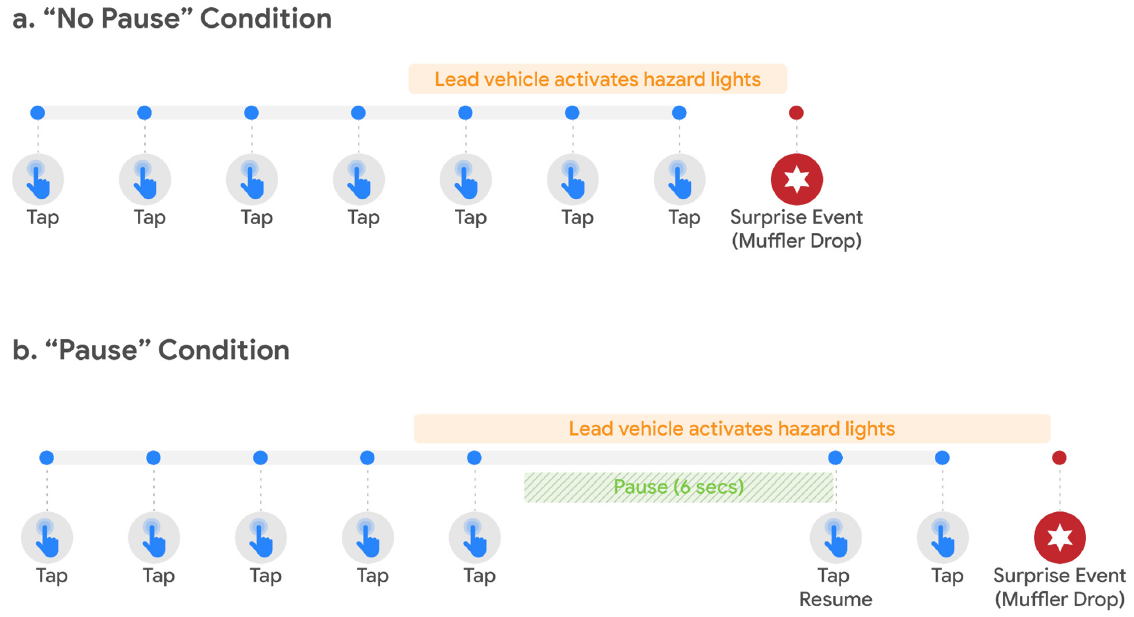
Figure 3. Timeline of events for the surprise event trial. ( a ) Shows the taps made on the display, when the lead vehicle’s hazard lights activated, and when the surprise muffler was dropped. ( b ) Shows the taps made on the display, when the lead vehicle’s hazard lights activated, when the driver was asked to pause the task, when the driver resumed the task, and when the surprise muffler was